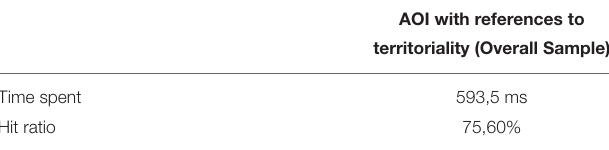
TABLE 3 | Average value of AOI related to territoriality.